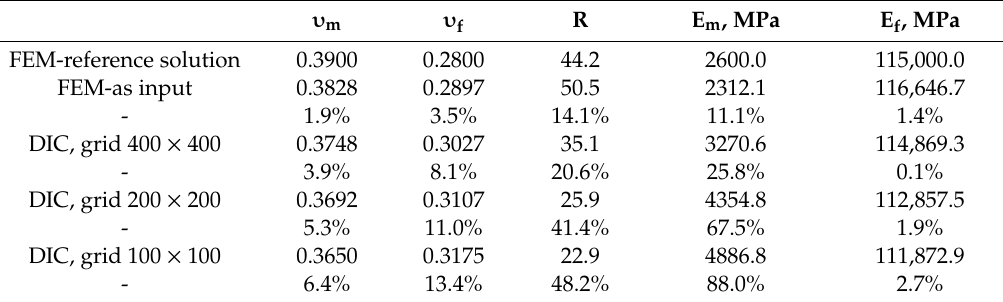
Table 6. Results of the identification of constituents properties for Material